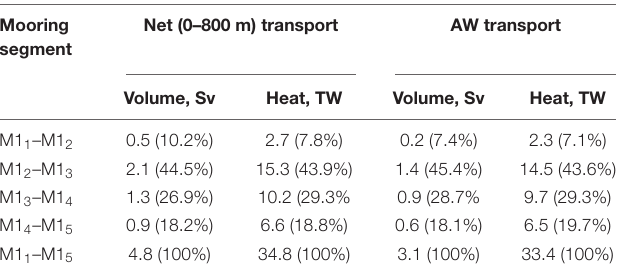
TABLE 3 | Transports between moorings and their relative contributions (numbers in brackets) to the net volume and heat transports across the Laptev Sea section in the upper ∼ 800 m and AW